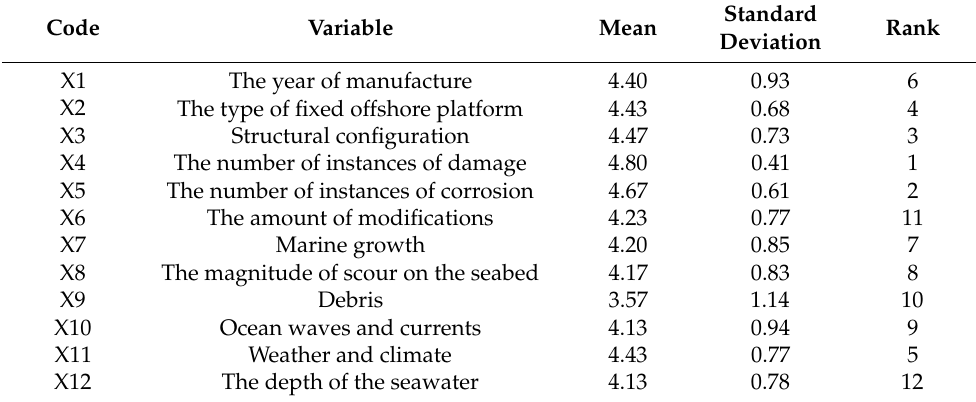
Table 3. Distribution data of